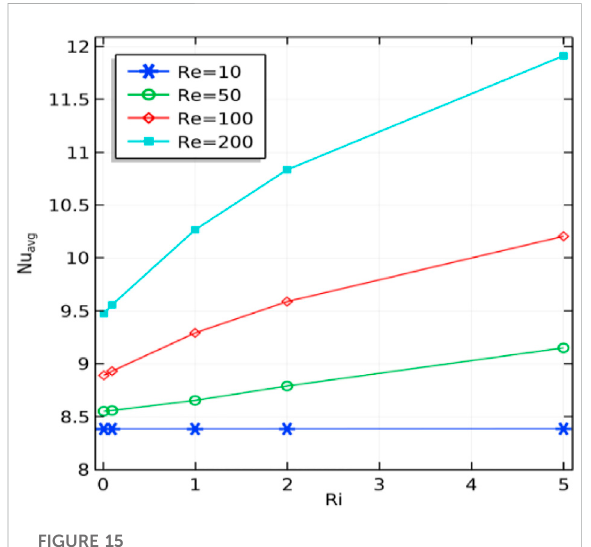
FIGURE 15 Variation of Nu avg at the bottom wall, Pr = 3, and Ha = 0: adiabatic